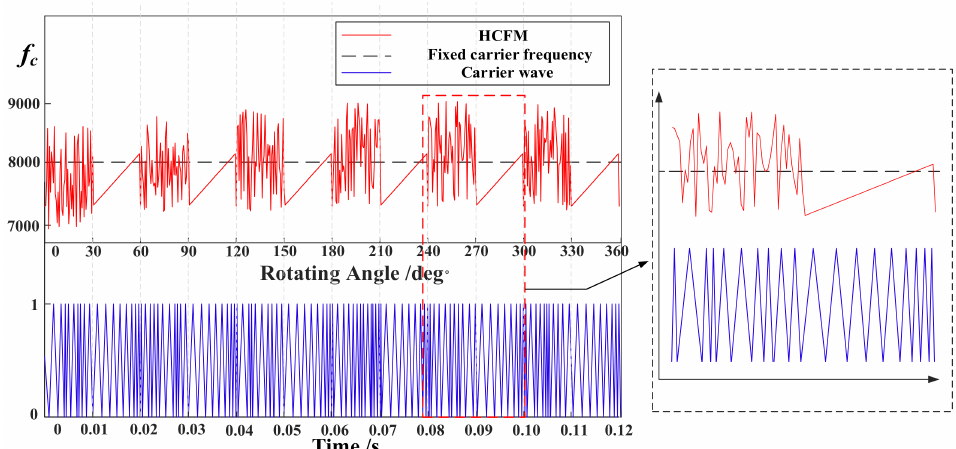
Figure 4. The variation laws and corresponding carrier waves of the carrier frequency with the